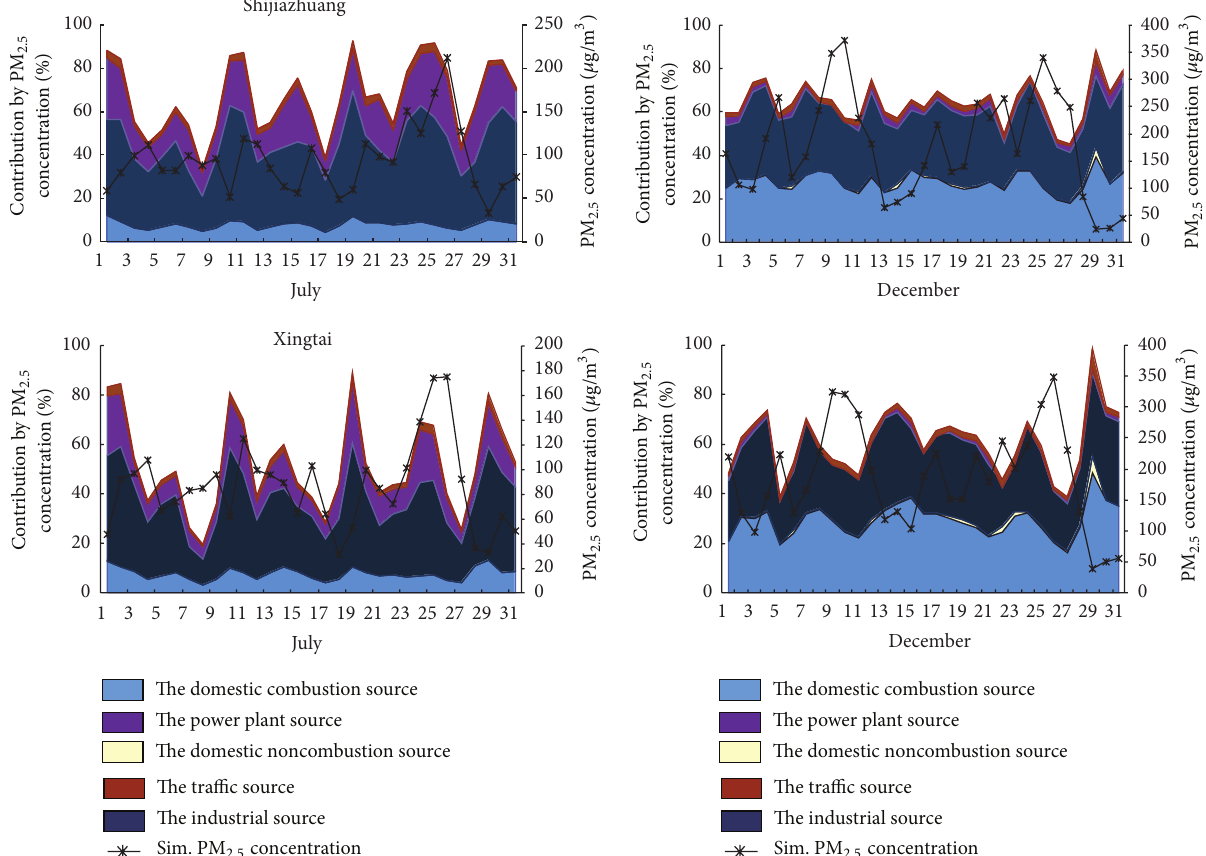
Figure 3: Contribution ratios of sector sources of Hebei area to daily average PM 2.5 concentration in Shijiazhuang and